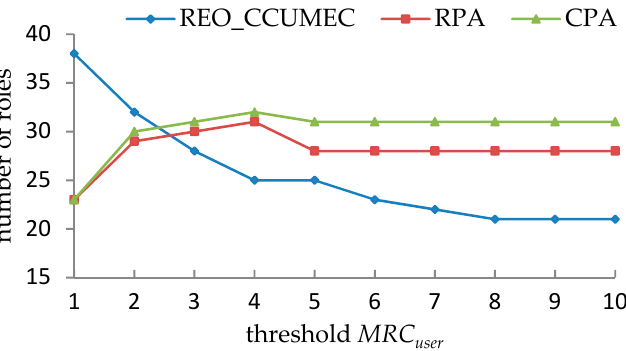
Figure 3. Performance comparison under the UCC in Domino.